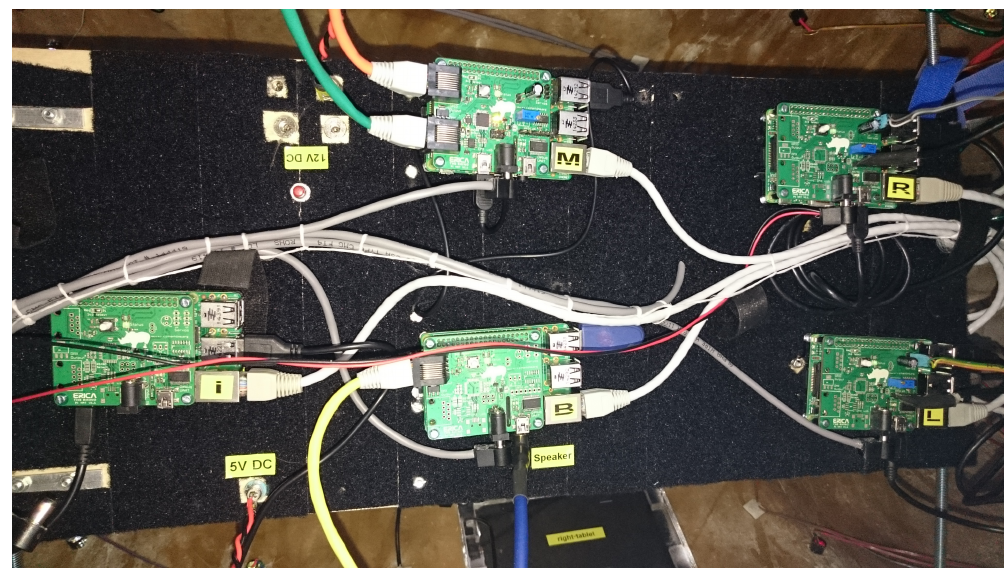
Figure 9. Erica’s main computing